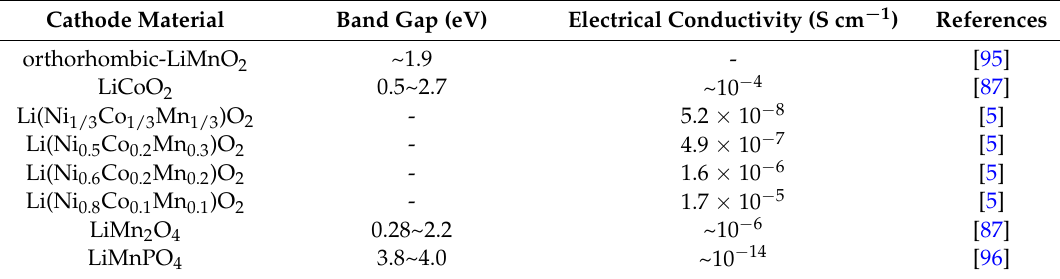
Table 4. Electrical conductivities of several cathodes at room